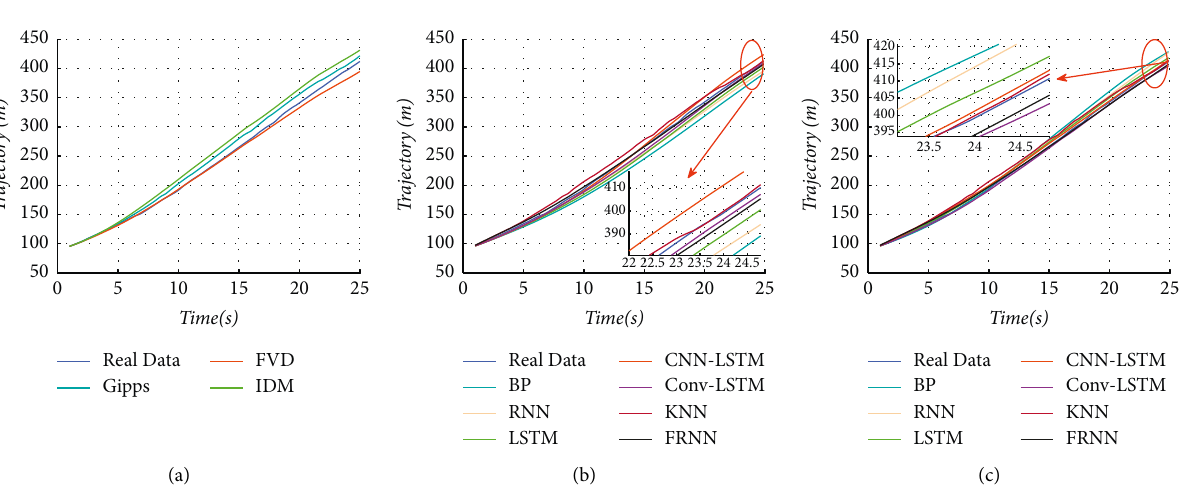
Figure 12: Trajectory comparison of continuous traffic flow. (a) Conventional model. (b) ANN CF-A. (c) ANN